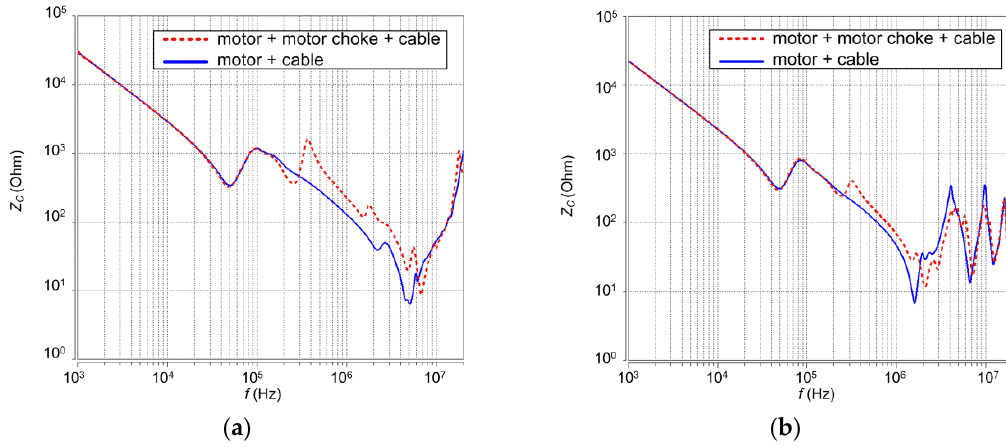
Figure 16. Measured impedance Z C (f) frequency characteristics: ( a ) motor + motor choke ( L D = 3.8 mH) + 1 m cable; ( b ) motor + motor choke ( L D = 3.8 mH) + 10 m cable.